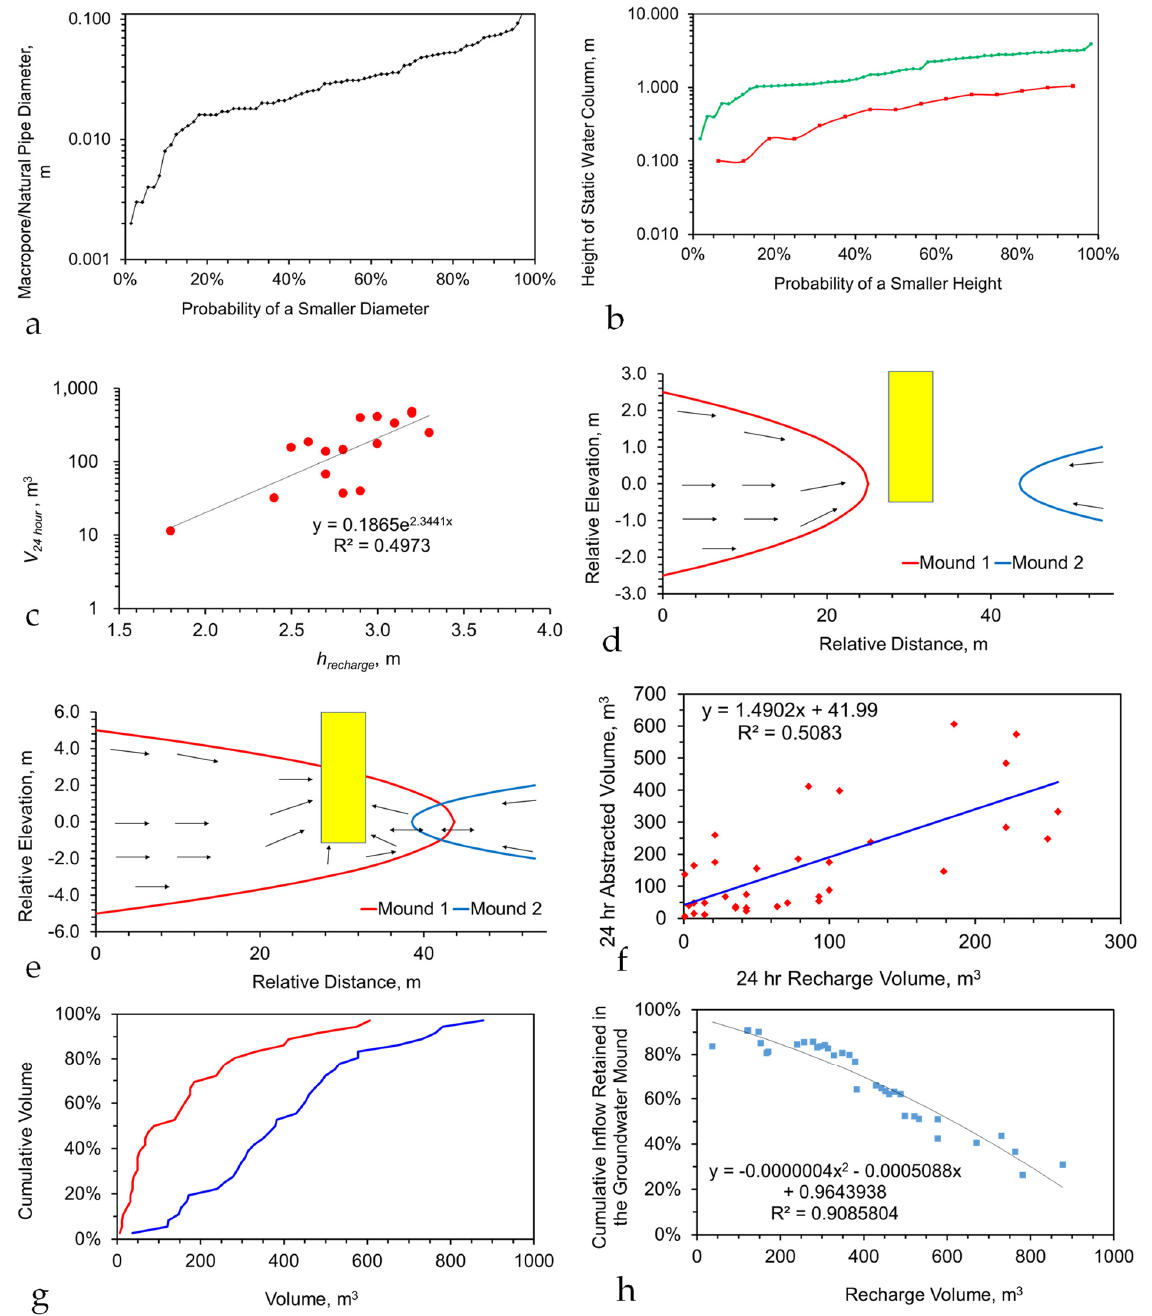
Figure A25. Example groundwater mound parameters in boulder clay, Central Scotland, UK. ( a ), macropore/natural pipe diameters; ( b ), relationship between water levels in the recharge device (green) and the abstraction device (red); ( c ), relationship between water levels in the recharge de- vice, and the water volume abstracted over a 24 h period from the abstraction device; ( d ), example placement of an abstraction device (yellow) between two groundwater mounds. Arrows indicate water flow directions; ( e ), example of a groundwater mound expanding its range to accommodate the presence of an abstraction device (yellow). Arrows indicate water flow directions; ( f ), example of recharge volumes to a groundwater mound, and associated discharge volumes; ( g ), relationship between cumulative infiltration/recharge (blue) into the groundwater mound and cumulative ab- straction (red) over a 15-day period; ( h ), relationship between cumulative inflow into a groundwater mound and cumulative outflow over a 15-day period.